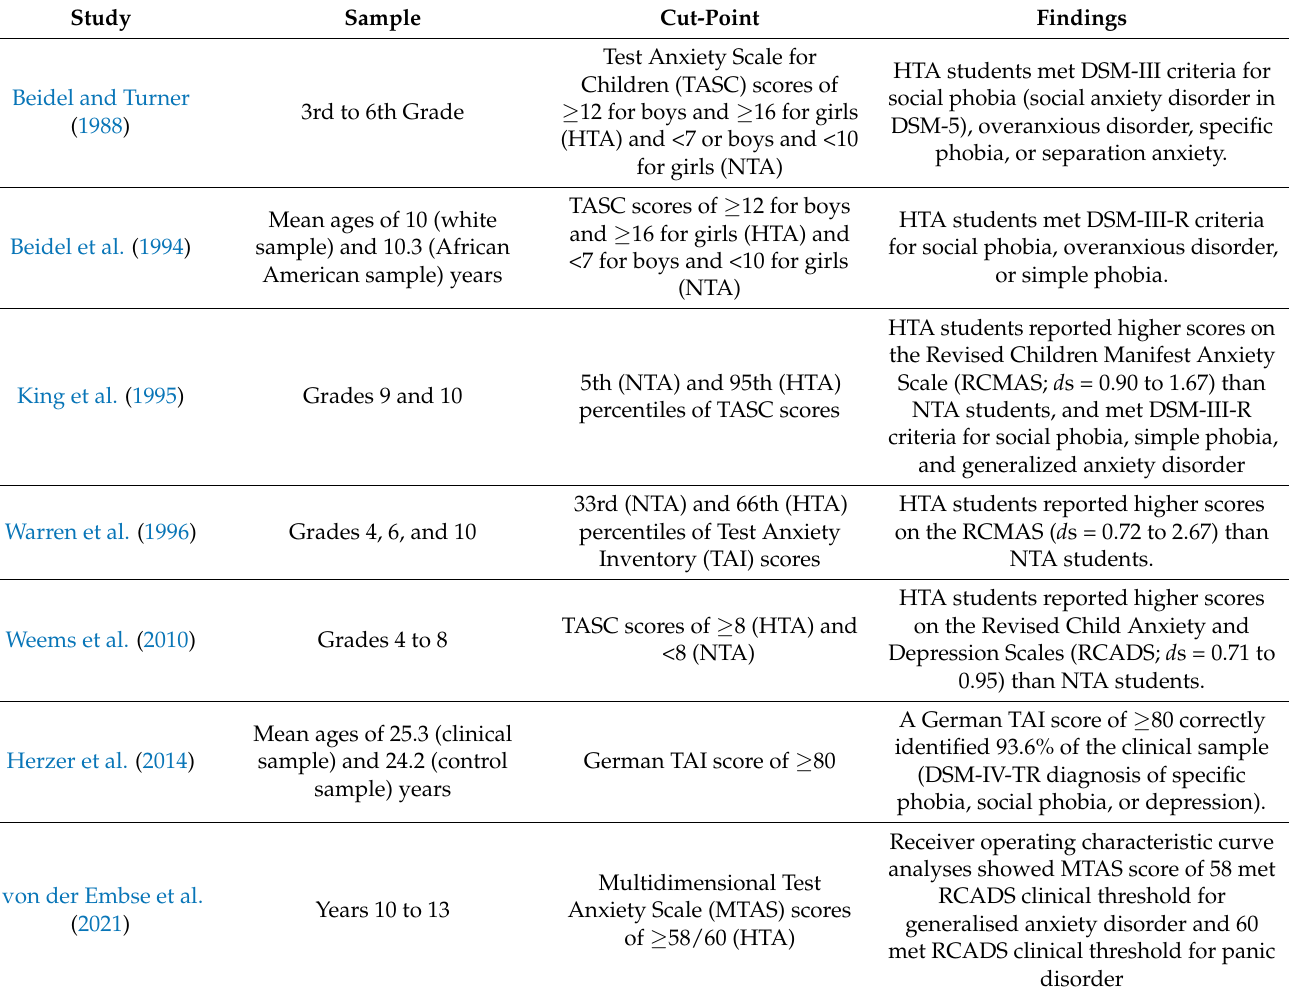
Table 1. Studies showing highly test anxious persons meet diagnostic thresholds for, and elevated indicators of, emotion